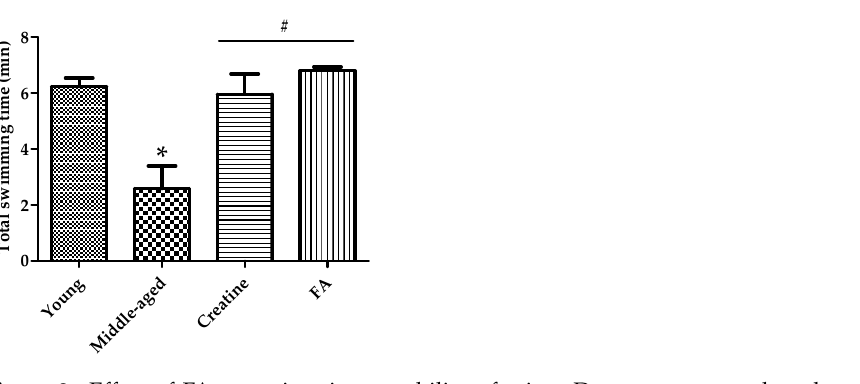
Table 2. Biochemical analysis of serum of different groups of mice after the exhaustive swimming test.